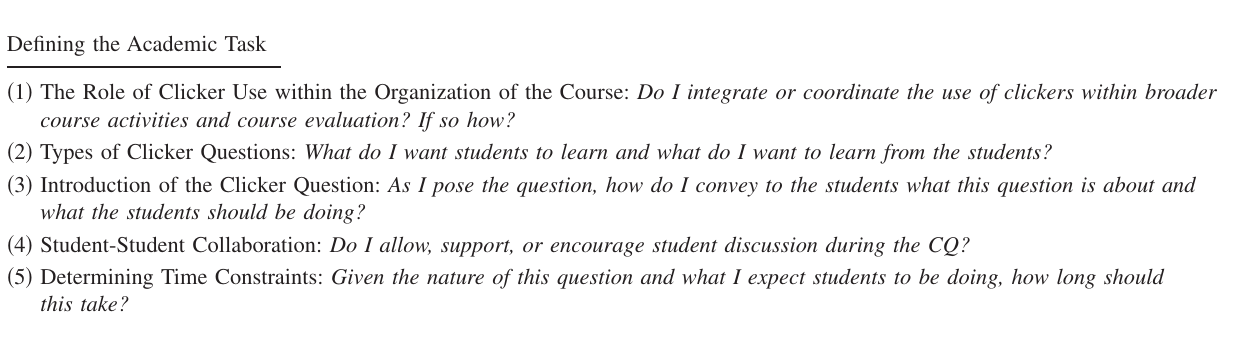
TABLE I. Summary of dimensions of practice. Dimensions of